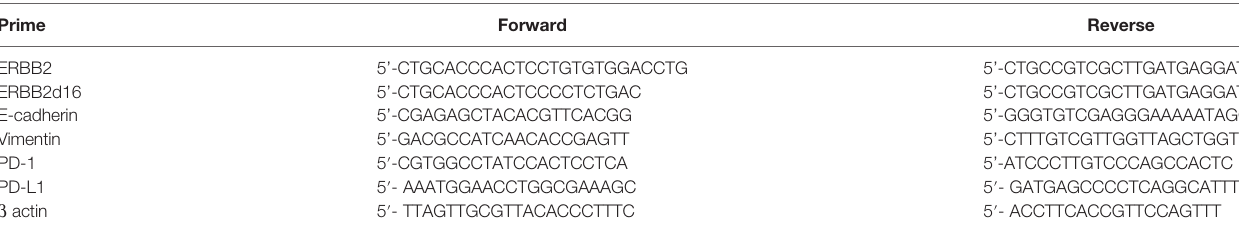
TABLE 2 | Prime sequence.